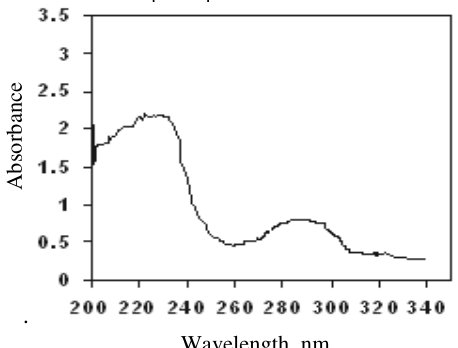
Figure 2. Duloxetine hydrochloride scanned in UV range (in 0.1 N